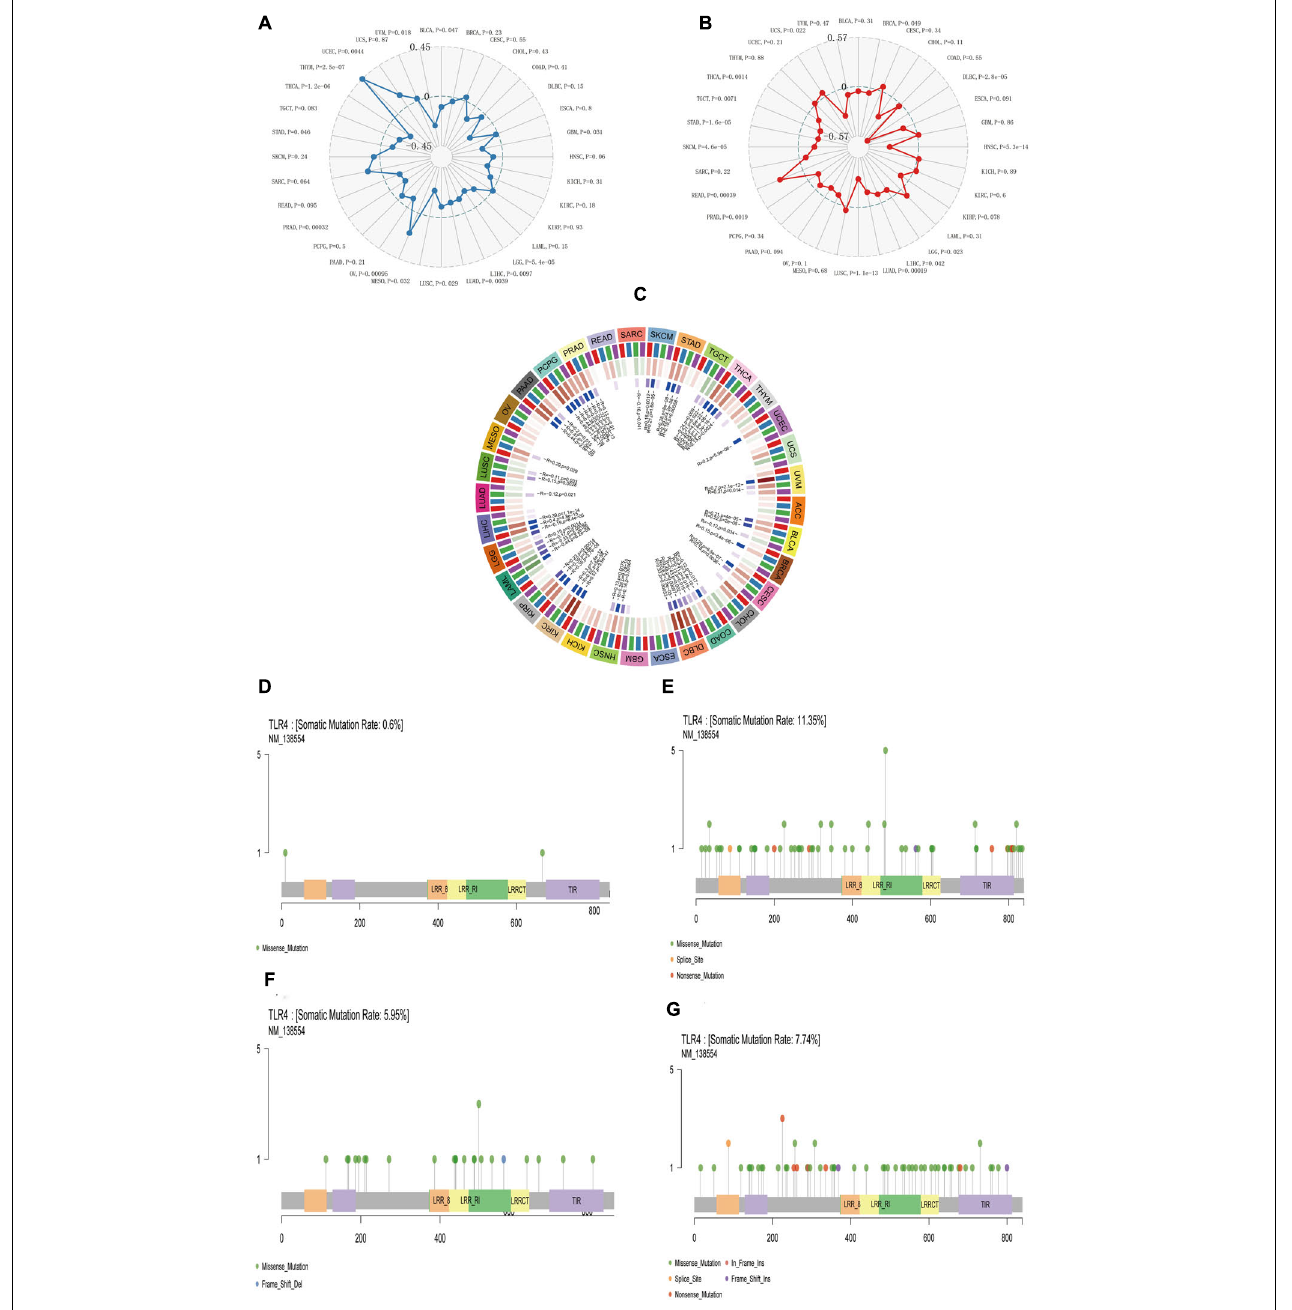
FIGURE 5 | The relationship between TLR4 gene expression and TMB, MSI, methyltransferase, and mutation frequency. (A) The expression of TLR4 gene was noticeably relevant to TMB in STAD ( p = 0.046) and UCEC ( p = 0.0044). (B) The expression of TLR4 gene in TGCT ( p = 0.0071), STAD ( p = 1.6e-05), and SKCM ( p = 4.6e-05) was significantly correlated with MSI. (C) The analysis outcomes revealed that the expression of TLR4 gene was conspicuously linked to methyltransferase DNMT2 and DNMT3B in SKCM and STAD ( p < 0.05) and was markedly correlated with methyltransferase DNMT2 in UCEC and KIRC ( p < 0.05). TCGA analysis displayed that the mutation rates of TLR4 gene in KIRC (D) , SKCM (E) , STAD (F) , and UCEC (G) were 0.6, 11.35, 5.95, and 7.74%,